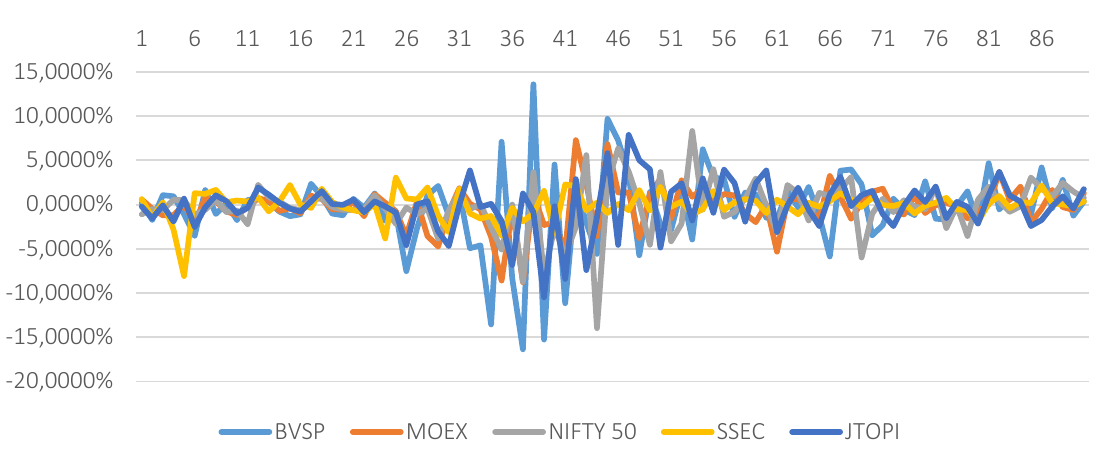
Figure 2. Abnormal returns for BRICS in the observation window